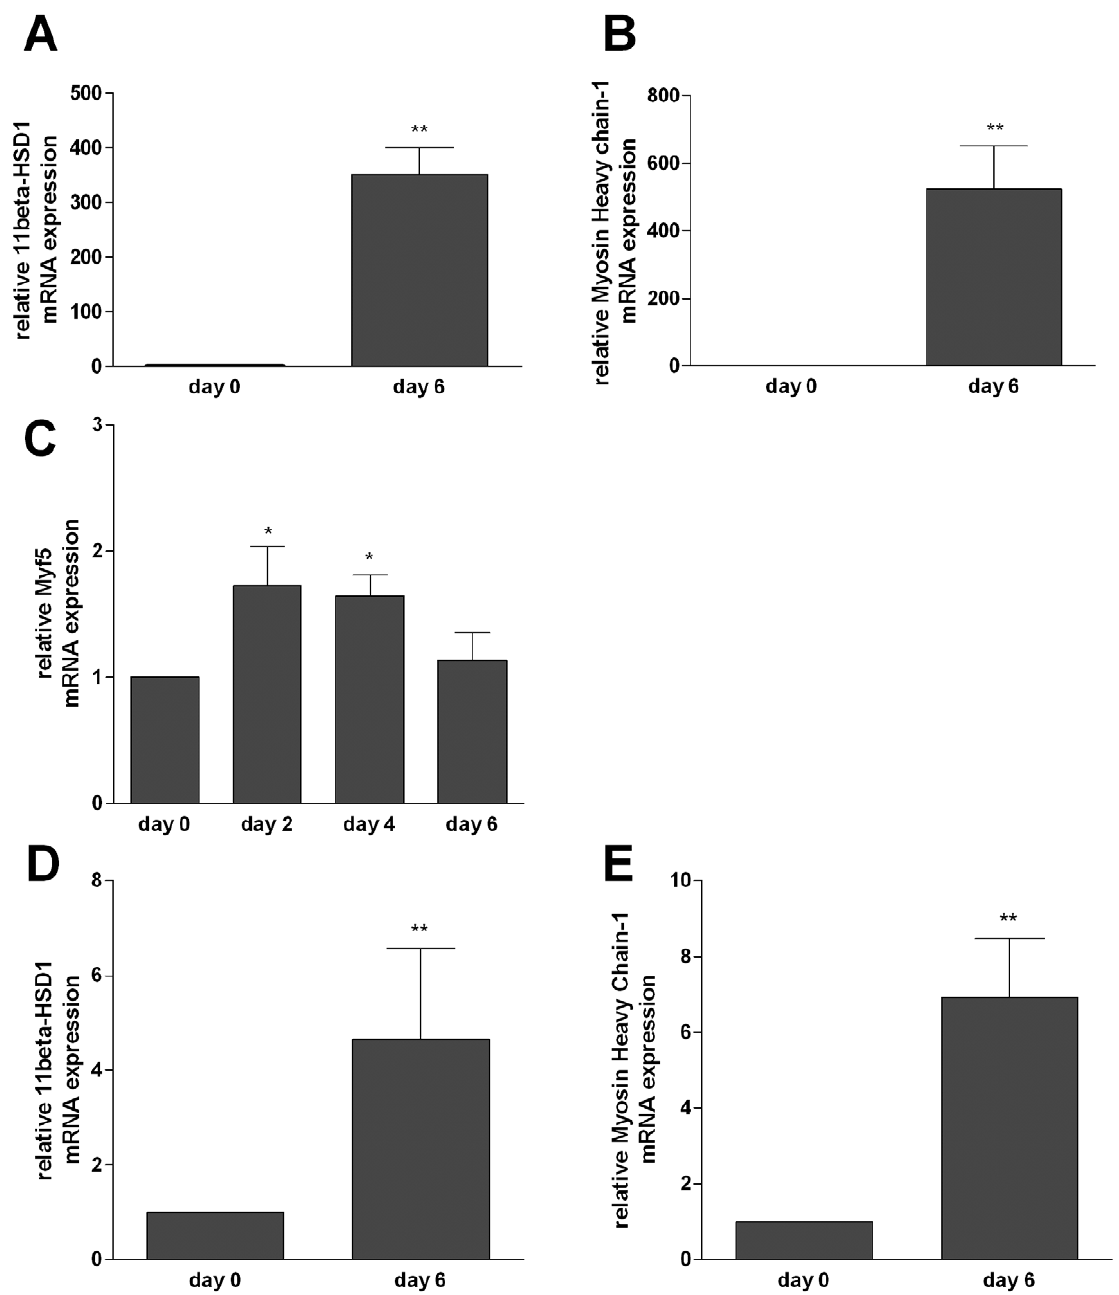
Figure 1. Regulation of 11beta-HSD1 and differentiation markers during differentiation of C2C12 cells and primary human myoblasts. Data were normalized to mRNA expression of 16s-RiboProtein. Mean 6 SEM of at least three experiments are shown. Relative 11beta- HSD1 mRNA expression in C2C12 ( A ). Relative Myosin Heavy Chain-1 mRNA expression in C2C12 cells ( B ). Relative Myf5 mRNA expression in C2C12 cells ( C ). Relative 11beta-HSD1 mRNA expression in primary human myoblasts ( D ). Relative Myosin Heavy Chain-1 mRNA expression in primary human myoblasts ( E ). * p , 0.05, ** p , 0.01, *** p , 0.0001.